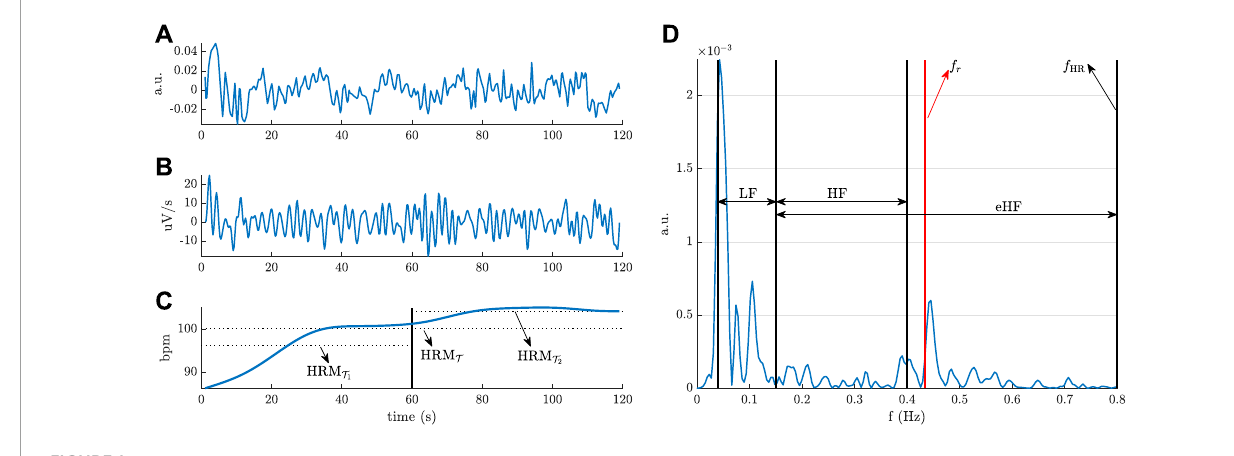
FIGURE 1 HRV analysis during the 2MWT (A) HRV signal, (B) EDR signal, (C) HR profile, and (D) HRV